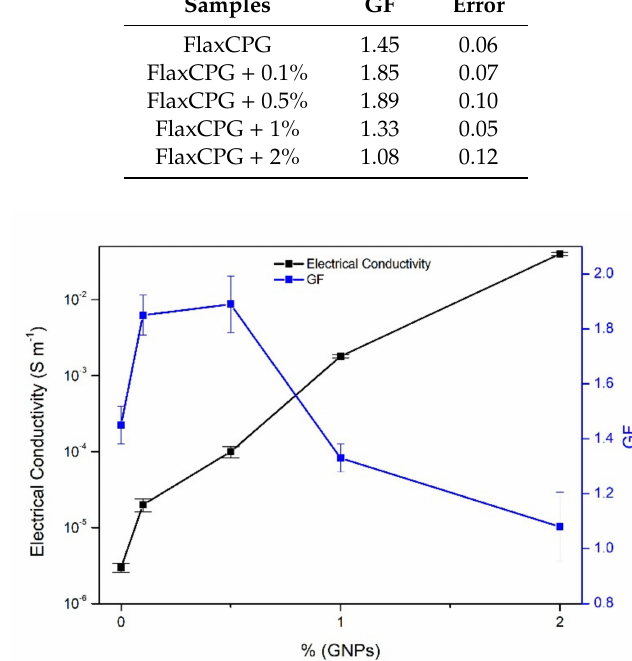
Figure 10. Relation between electrical conductivity and